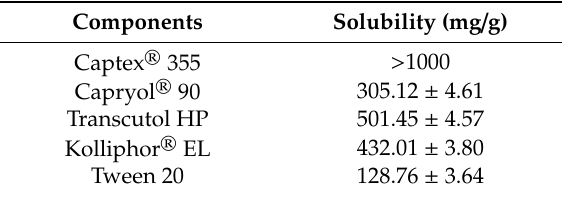
Table 1. Solubility of retinyl palmitate in di ff erent oils, surfactants, and